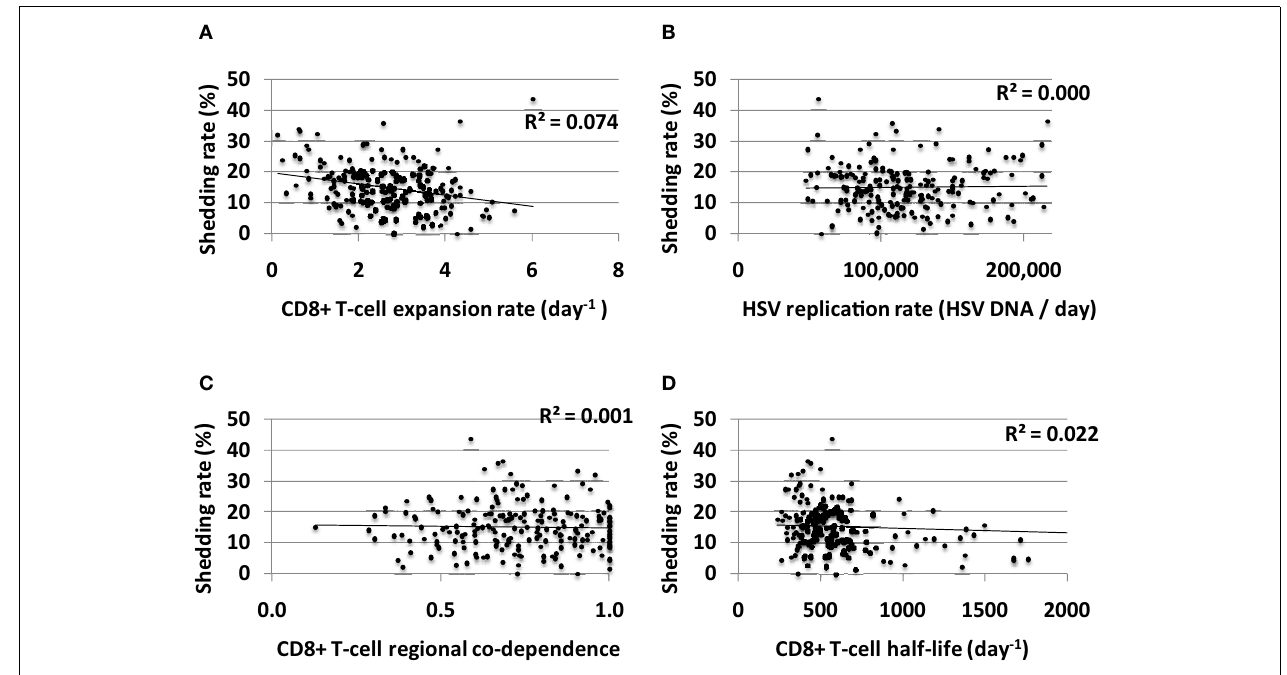
impact on shedding rate. (C) CD8 + T-cell regional co-dependence, a model parameter that dictates the range over which these cells provide protection, has no impact on shedding rate. (D) Longer CD8 + T-cell half-life weakly predicts lower shedding rate.